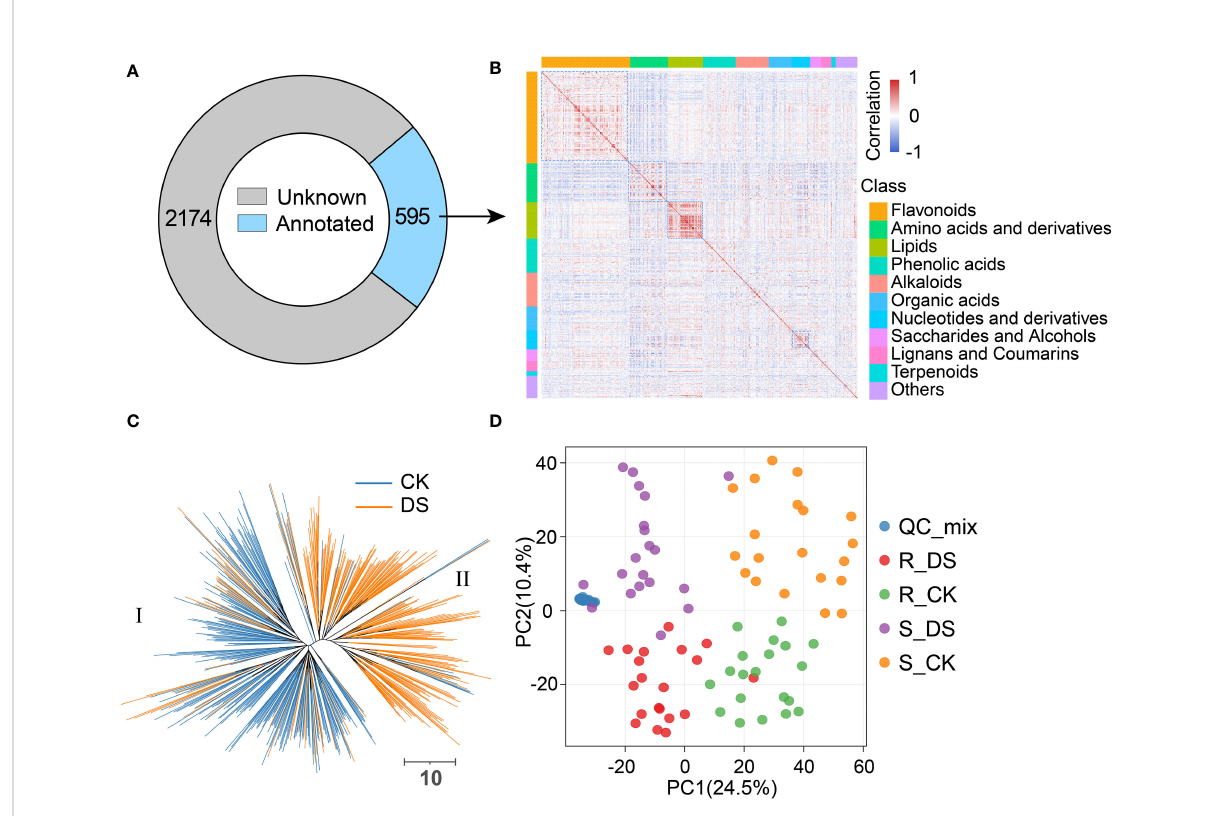
FIGURE 2 Classi fi cation and statistics of metabolites in qingke. (A) Metabolic features detected in qingke leaves, unknown and annotated are represented in gray and light blue, respectively. (B) Heatmap of correlation (spearman) among annotated metabolites, red indicates positive correlation and blue indicates negative correlation. The color blocks on the top and left represent the class of metabolites. (C) Neighbor-jointing phylogenetic tree constructed using metabolites identi fi ed in qingke leaves before and after drought stress. Two major clades, represented by CK and DS, were identi fi ed from the tree. The scale bar indicates the simple matching distance. (D) Principal component analysis (PCA) score plot showing distinctive metabolic pro fi les of drought-resistant qinge (R) and drought-sensitive qingke before (CK) and after (DS) drought stress. The blue dot represents the mixed sample used for the quality control in metabolite